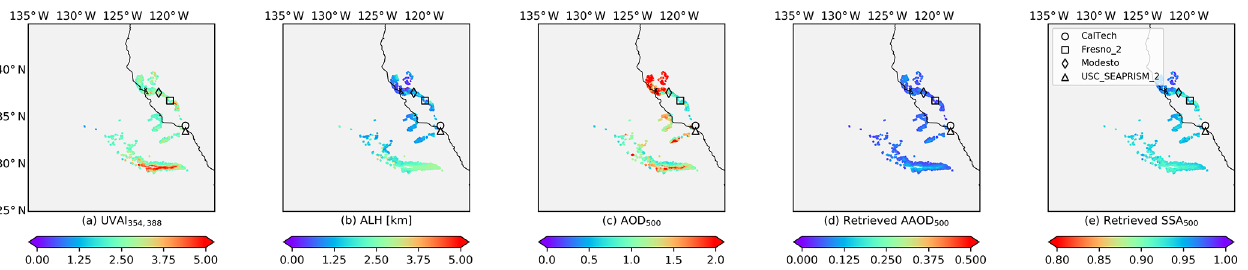
Figure 12. SVR retrievals for the Californian fire event on 10 November 2018: (a) TROPOMI UVAI calculated by reflectance at 354 and 388nm; (b) TROPOMI ALH; (c) MODIS AOD at 550nm; (d) retrieved AAOD at 500nm; (e) retrieved SSA at